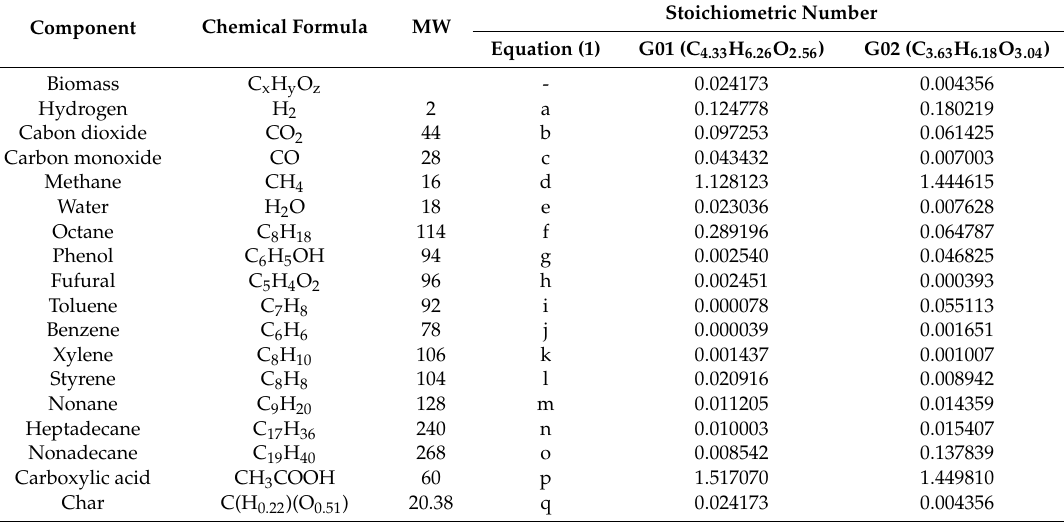
Table 4. The optimum set of stoichiometric numbers for pyrolysis model G01 and model G02.